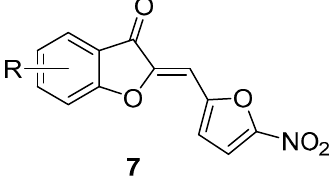
Figure 2. Structure of ( Z )-2-[(5-nitrofuran-2-yl)methylene]benzofuran-3(2 H )-ones 7 .